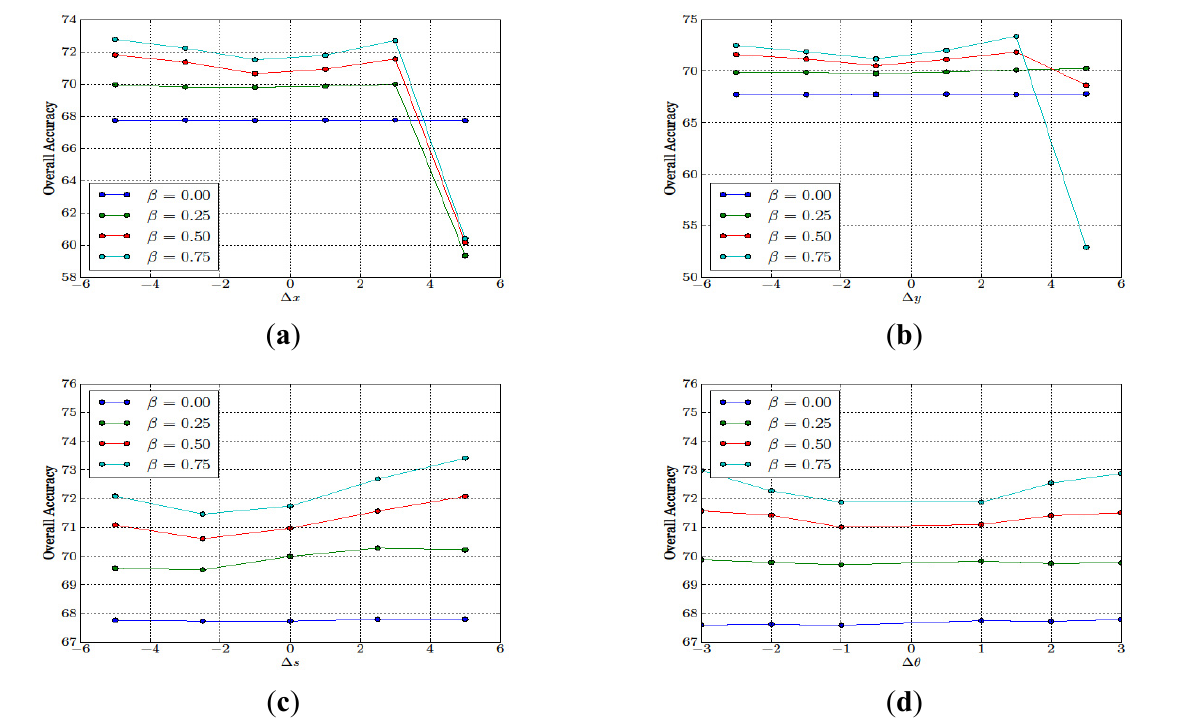
Figure 13. The effect of initial registration errors to the overall accuracies for ( a ) in the x -direction; ( b ) in the y -direction; ( c ) in the scale; and ( d ) in the rotation.